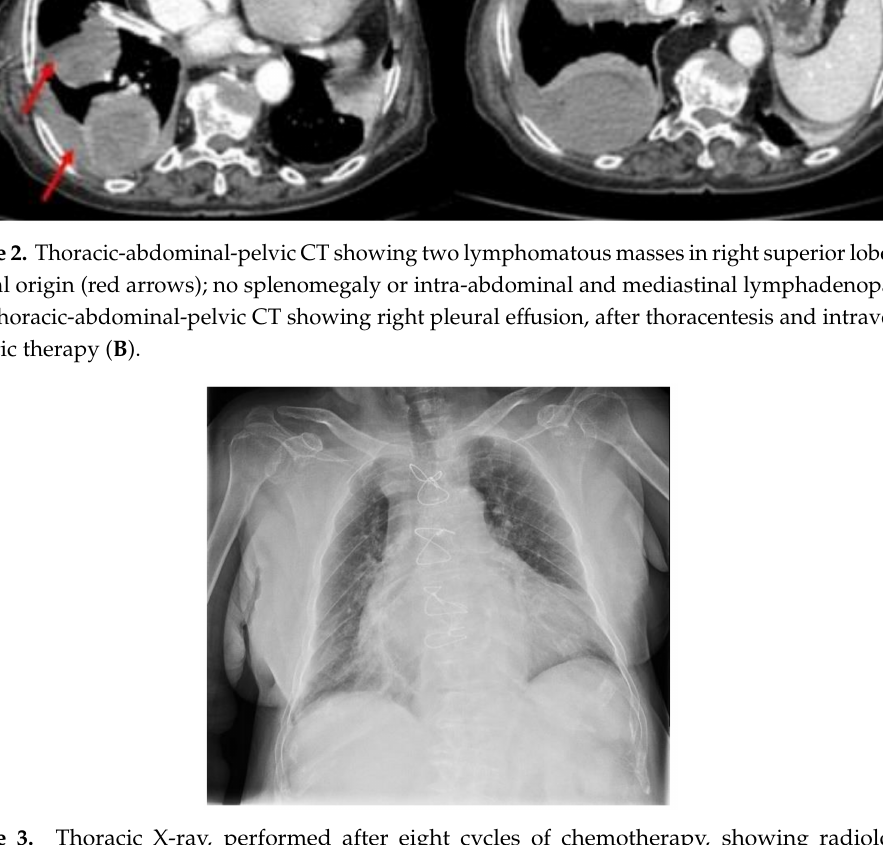
Figure 3. Thoracic X-ray, performed after eight cycles of chemotherapy, showing radiological improvement, without right pleural e ff usion.